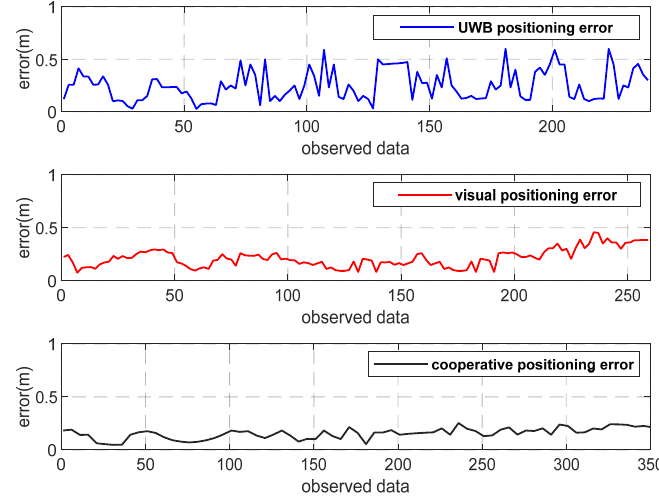
Figure 11. Error of the Y -axis.